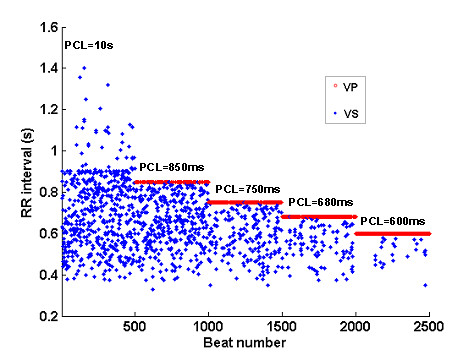
Example of simulated RR intervals in the presence of AF and VP.